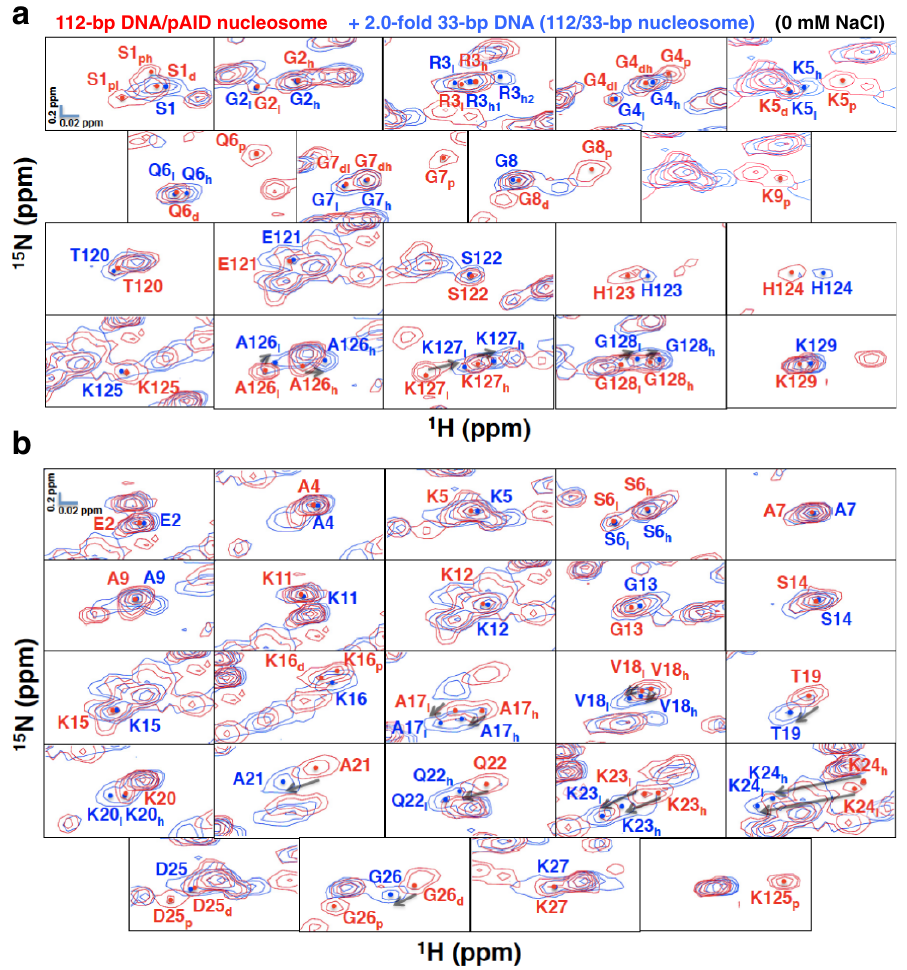
Fig. 2 Comparison of extended HSQC spectra of the H2A and H2B tails between the 112-bp DNA/pAID nucleosome alone (red) and with the two-fold addition of 33-bp DNA (blue). a , b NMR signals are divided into panels by amino acid residue of H2A ( a ) and H2B ( b ). Signal assignments in the 112-bp DNA/pAID nucleosome alone and with the two-fold addition of DNA at 0 mM NaCl are labeled in red and blue, respectively. Two-fold addition of 33-bp DNA to the 112-bp DNA/pAID nucleosome leads to a double-strand break nucleosome wrapped by 112-bp and 33-bp DNA (112/33-bp nucleosome), as shown in Supplementary Fig. 2a. Filled circles indicate each signal center. The signal centers were identi fi ed from peaks in the slice representations of signals in Supplementary Fig. 1. pAID and DNA side signals are designated by subscript p and d, respectively. High- and low- fi eld components of the signals are designated by subscript h and l, respectively. Arrows represent chemical shift changes upon the addition of 33-bp